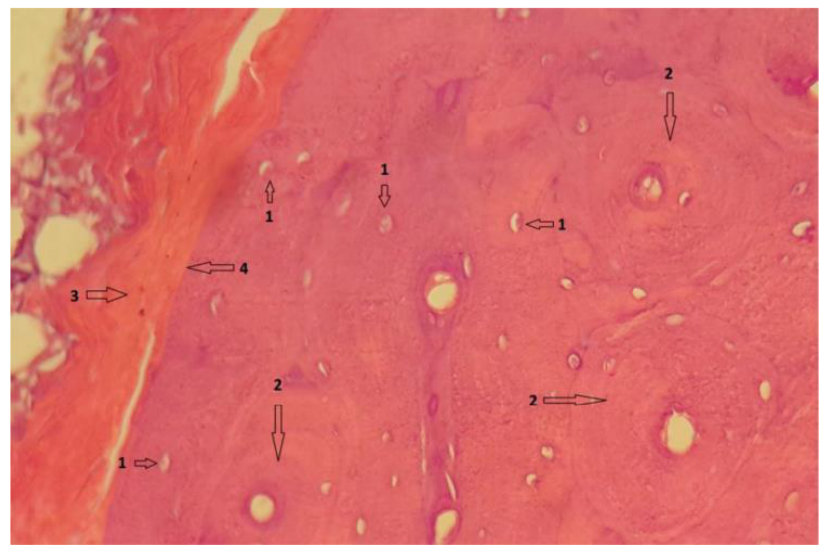
Figure 21. Bone section showing viable bone cells, with intracytoplasmic nucleus, visible in section,